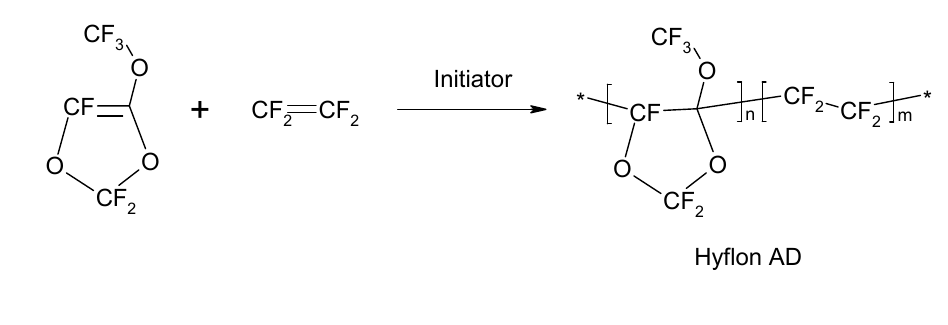
Figure 11. The preparation of Hyflon